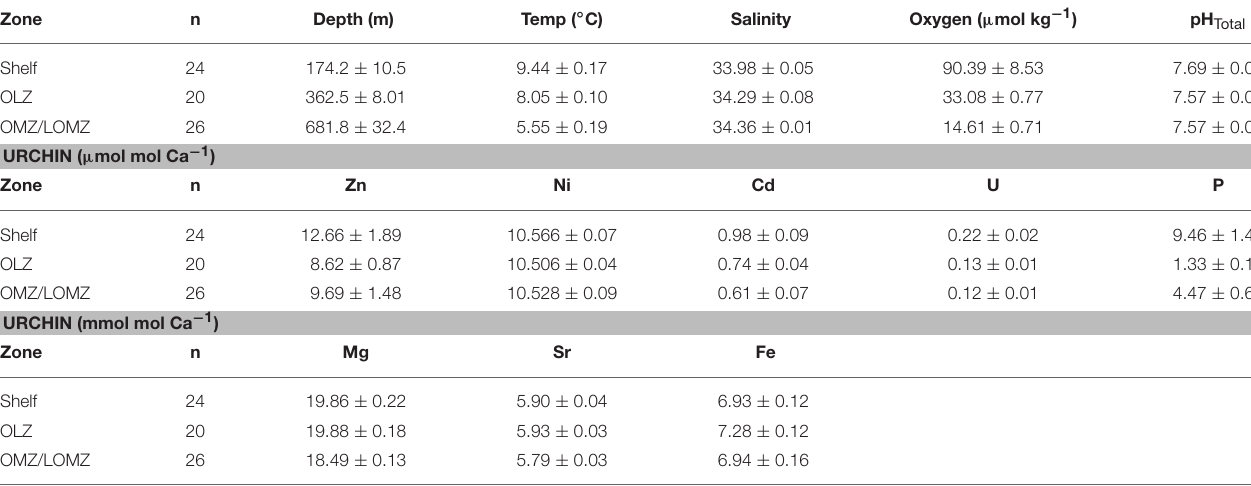
TABLE 2 | Mean values ( ± 1 SE) of hydrographic variables (Depth, Temperature, Salinity, Oxygen, and pH Total ) and [E/Ca urchin ] ratios of Strongylocentrotus fragilis urchin tests separated by depth zone bin. Zone n